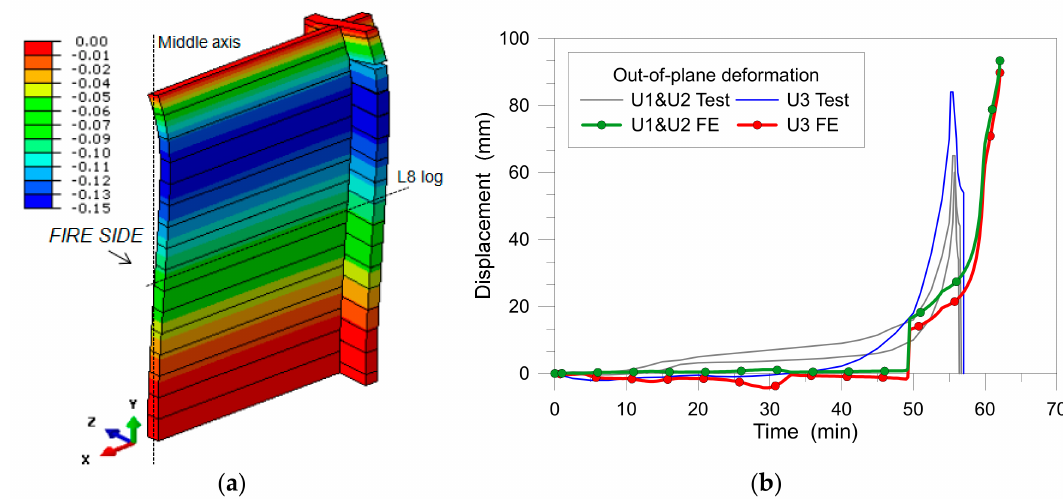
Figure 11. FE mechanical results (ABAQUS). ( a ) Deformed shape after 50 min of EN/ISO standard time-temperature exposure (out-of-plane deformations in meters—mesh pattern hidden from the 3D view); with ( b ) experimental-numerical evolution of out-of-plane displacements, as a function of time, as obtained from the U1, U2 and U3 control